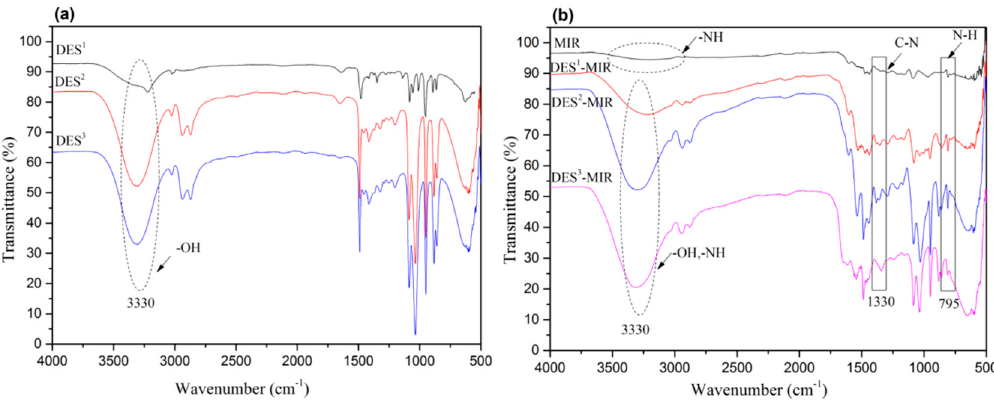
Figure 1. ( a ) Fourier transform infrared (FTIR) spectra of DESs (DES 1 , DES 2 and DES 3 ) and ( b ) DES-molecularly imprinted resin (MIR) (DES 1 -MIR, DES 2 -MIR and DES 3 -MIR).